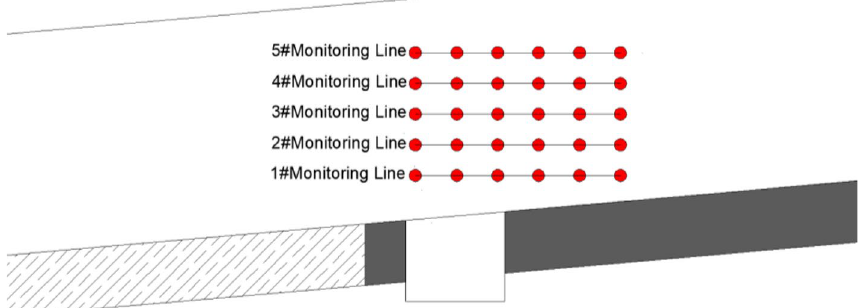
Figure 4. Layout of monitoring line.